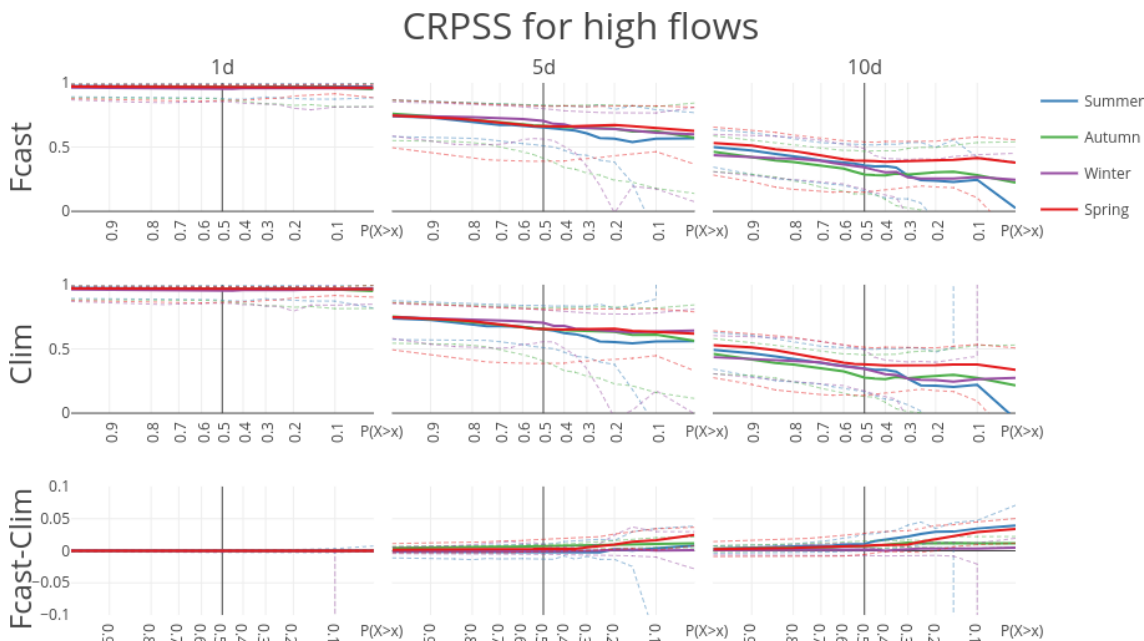
Figure 8. CRPSS for forecast runs (forecasted PET, climatological PET) and their difference benchmarked against model output for the 20 largest sub-catchments in the Rhine basin. CRPSSs are aggregated into mean (solid), 10th and 90th percentiles (dashed). Note that the CRPSS at P(X ≥ x) = 0 . 1 or 0.7 is calculated over, respectively, the 10% and 70% highest observation–forecast pairs, conditioned on the observations.